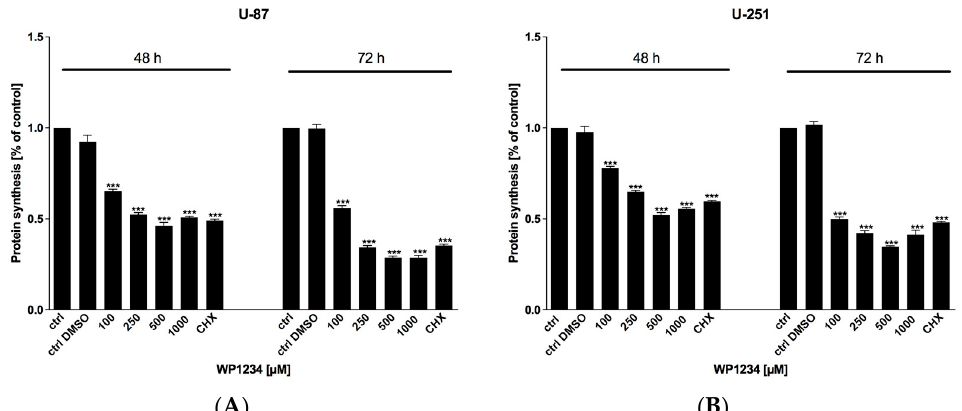
Figure 4. Intracellular protein synthesis of ( A ) U-87 and ( B ) U-251 in response to 48 and 72 h treatment with various concentrations of WP1234 (100–1000 μ M). As a reference cytotoxic agent, CHX (20 μ M) was used. Significant differences between the treatment and control (untreated cells) means are indicated by * p < 0.05, ** p < 0.01, *** p < 0.001.